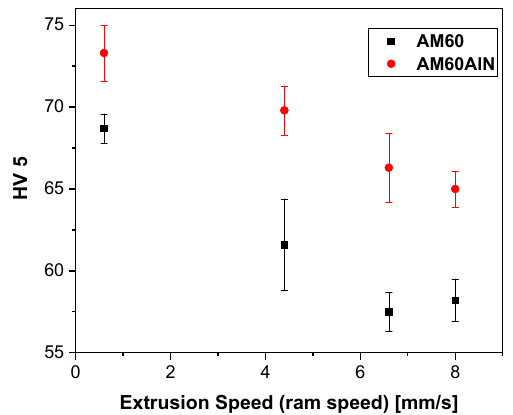
Figure 6. Hardness of extruded AM60 and AM60 + 1 wt.% AlN series.